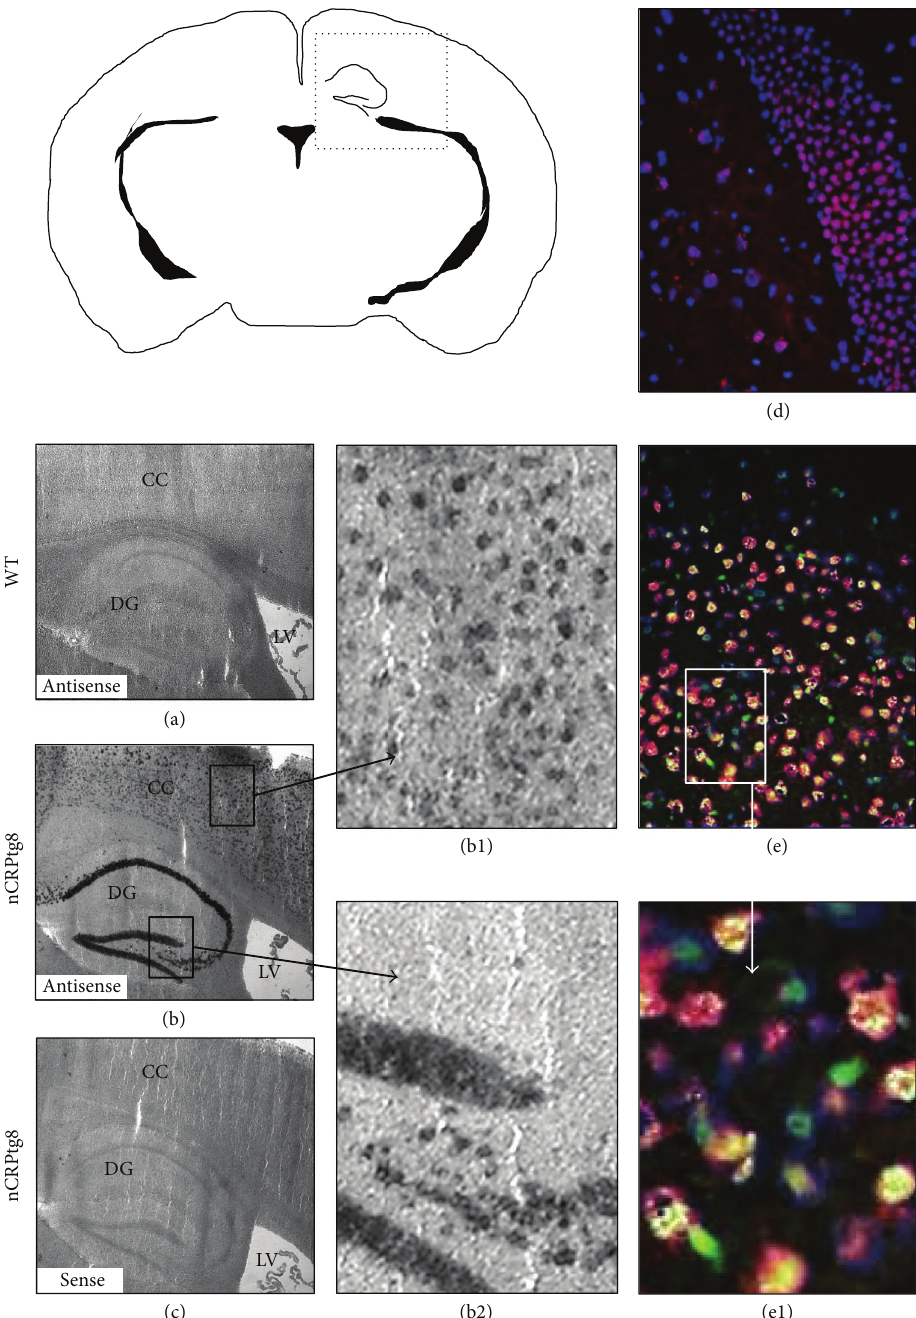
Figure 2: CNS-restricted expression of the CaMKII 𝛼 -driven human CRP transgene and CRP production in the CNS of nCRPtg mice. ((a)– (c)) Thin coronal sections of brains from a wildtype (WT, (a)) and a nCRPtg mouse ((b) and (c)) were incubated with a digoxigenin-labelled antisense probe to localize human CRP mRNA or with a similarly labeled sense probe to reveal nonspecific hybridization. Note the strong hybridization signals generated by the antisense probe in the cerebral cortex (CC) and dentate gyrus (DG) of nCRPtg mice ((b); (b1) and (b2) are tenfold magnifications of the areas indicated). LV = lateral ventricle. ((d)-(e)) Frozen sections of wild type (d) and nCRPtg brains ((e); (e1) is a tenfold magnification of the indicated area) were incubated with a FITC-conjugated anti-human CRP antibody (green) and a Texas Red-conjugated anti-NeuN antibody (red). An orange-yellow color indicates colocalization of the FITC and Texas Red signals. DAPI (blue) was also used to stain cell nuclei. The dashed box in the cartoon shows the approximate position and orientation of the thin sections shown in